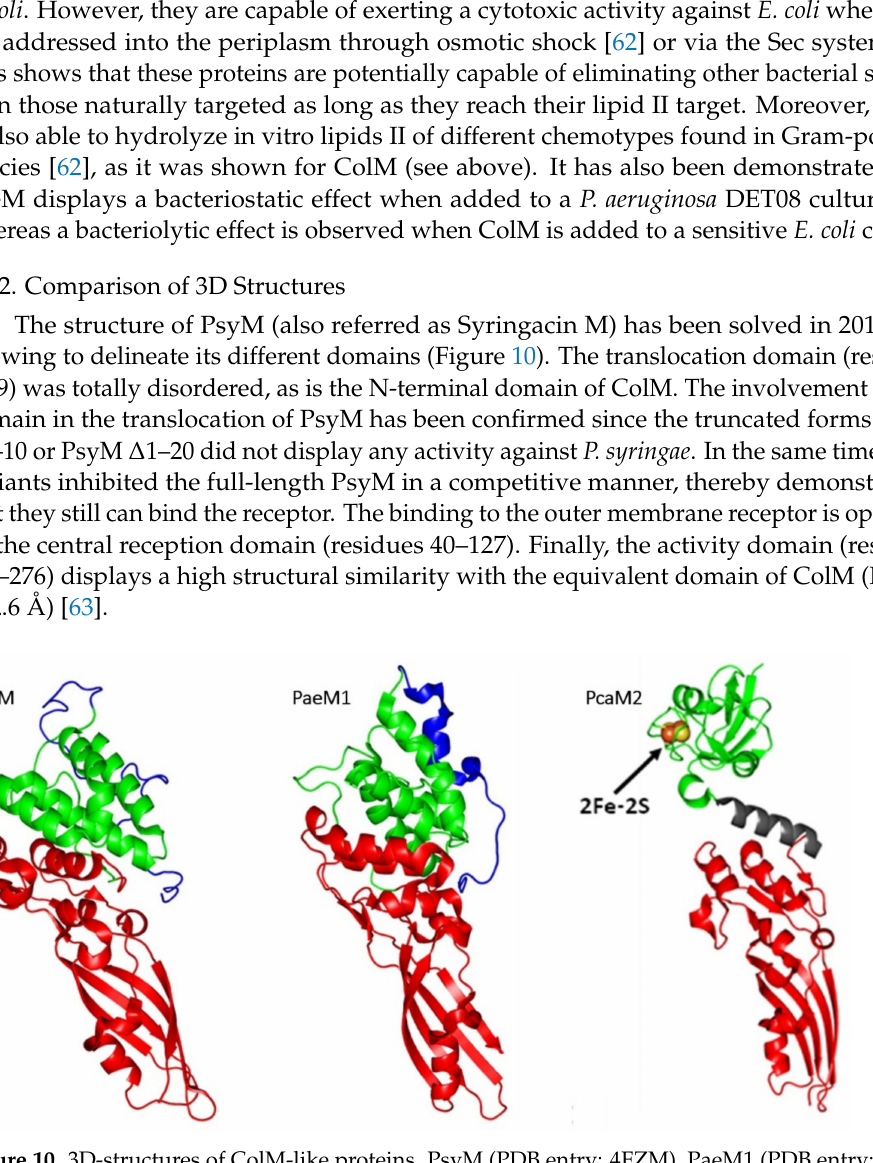
Figure 10. 3D-structures of ColM-like proteins. PsyM (PDB entry: 4FZM), PaeM1 (PDB entry: 4G76), PcaM2 (stretched form; PDB entry: 4N58). For all structures, the translocation domain is colored in blue, the reception domain in green and the activity domain in red. 2Fe-2S: [2Fe-2S] cluster. The figure was prepared with the atomic coordinates from the PDB by using PyMOL (DeLano